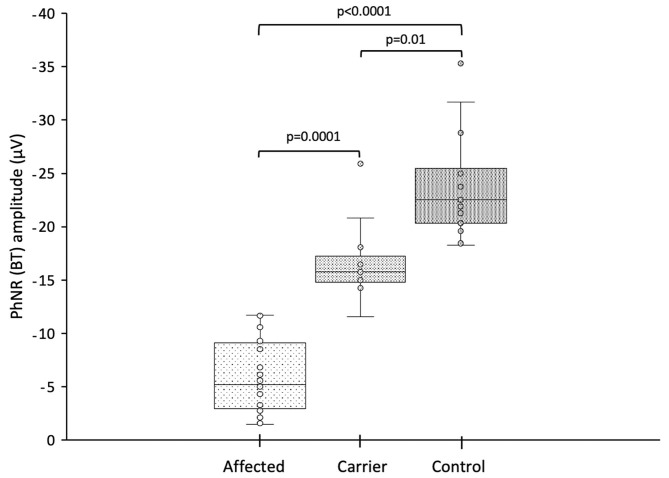
Photopic negative response amplitude (BT) from LHON affected patients, LHON asymptomatic carriers and controls (each box shows the median, quartiles, and extreme values; circles represent the subjects).